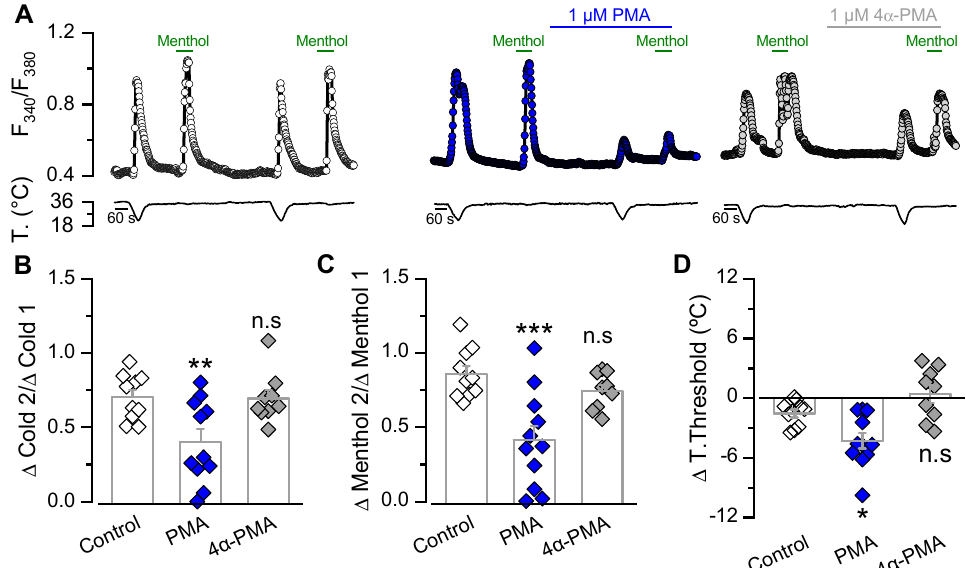
Figure 4. PKC activation by PMA downregulates the responses to cold and menthol in cold-sensitive neurons. ( A ) Ratiometric [Ca 2+ ] i response of representative cold thermoreceptor/menthol-sensitive neuron, from mouse TG. The protocol used consisted of a double application of a cold pulse followed by application of 100 µM menthol at 34 °C in cells perfused with control solution (open circles), 1 µM PMA (blue circles) or 1 µM 4 α -PMA (grey circles). ( B , C ) Bar graph representing mean and S.E. and data points of ratio responses to cold ( Δ C2/ Δ C1) ( B ) and menthol ( Δ M2/ Δ M1) ( C ) for each condition. ( D ) Summary of the effect of different treatments on the temperature threshold of cold-evoked responses (T2-T1). Negative values indicate shifts towards lower temperatures (control, n = 10; PMA, n = 11 and 4 α -PMA, n = 9). Statistical significance was assessed using a one-way ANOVA test in combination with a Dunnett’s post hoc test; *** p < 0.001, ** p < 0.01 and * p < 0.05, n.s. (not significant) p > 0.05 compared to control conditions.